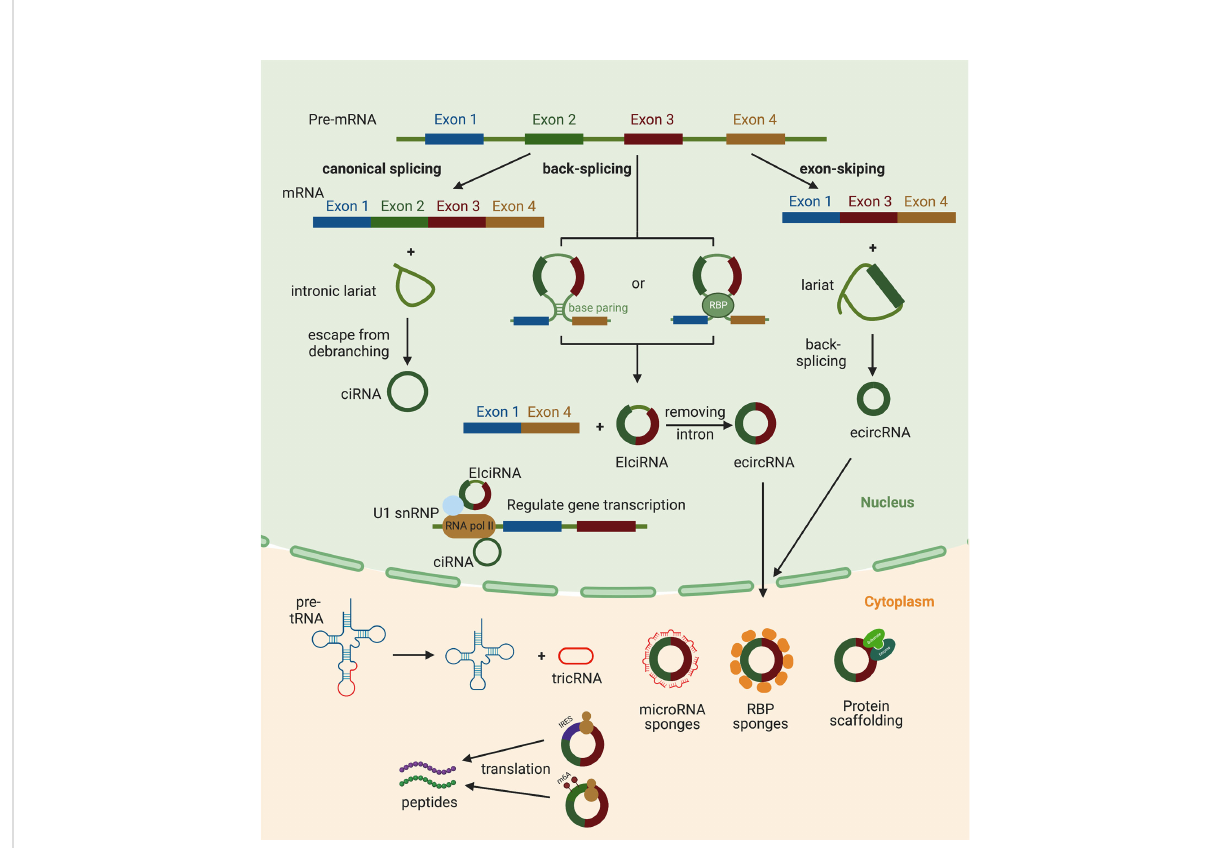
FIGURE 1 The biogenesis and functions of circRNAs. Exonic circRNAs (EcircRNAs) are generated by a non-canonical back-splicing which is favored by the base paring between reverse complementary sequences (such as Alu repeats) and the dimerization of RNA binding proteins (RBPs). EcircRNAs can also be produced from splicing intermediates called as lariat precursors that are created by an exon-skipping event. Circular intronic RNAs (ciRNAs) are generated from intronic lariats that escape from the debranching step of canonical linear splicing. tRNA intronic circular RNAs (tricRNAs) are formed during the process of pre-tRNA splicing. CiRNAs and EIciRNAs are located in nucleus. CiRNAs can interact with the RNA pol II complex and play a role in regulating parental gene transcription. EIciRNAs can interact with U1 small nuclear ribonucleoproteins and then increase the transcription of their host genes by binding with RNA pol II. EcircRNAs are translocated to cytoplasm after formation, and can act as microRNA sponges, RBP sponges, protein scaffoldings or templates of protein